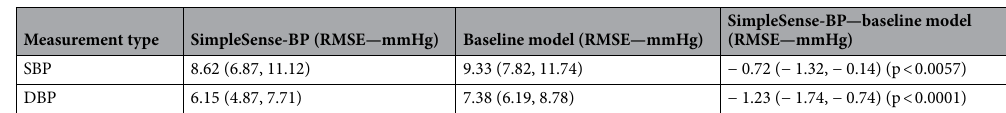
Table 2. Results of the bootstrap RMSE analysis for each model SimpleSense-BP, baseline model using demographics data only, and the difference between the paired measurements of RMSE between the models.